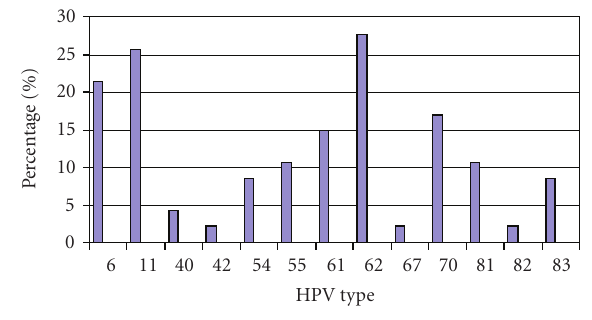
Figure 1: Low risk HPV type distribution.